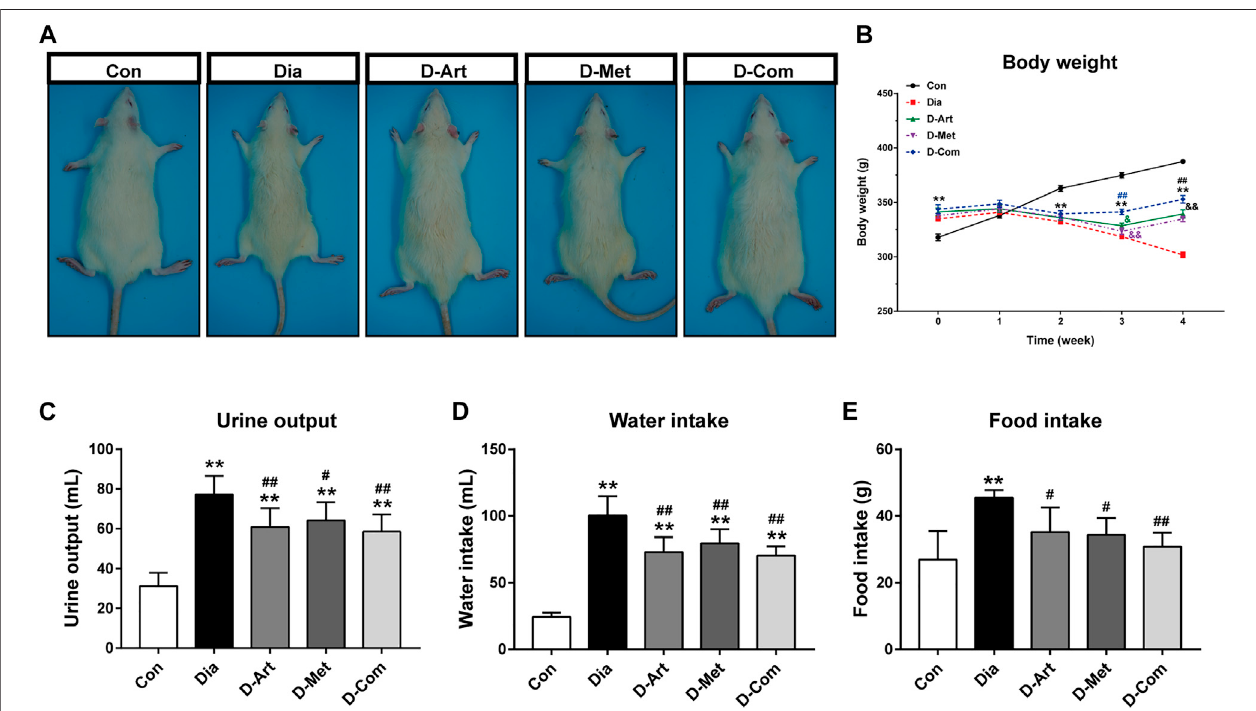
FIGURE 2 | ART or Met alone and ART/Met combination alleviate general conditions in the T2DM rats. (A) Gross appearance of each group of rats. (B – E) Body weight,urineoutput,waterintake,andfoodintakeinratsofeachgroup(8ratspergroup).Dataareexpressedasthemean ± SD.** p < 0.01versusCongroup;# p < 0.05 and ## p < 0.01 versus Dia group. Con, Normal control group; Dia, Untreated diabetic group; D-Art, ART-treated diabetic group; D-Met, Met-treated diabetic group; D-Com, ART/Met co-treated diabetic